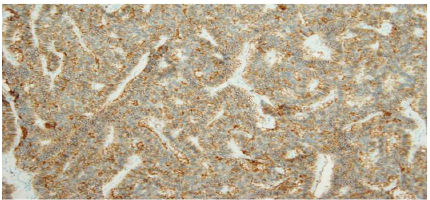
Figure 5: Neural cell adhesion molecule-stained section. Tumor cells are positive for neural cell adhesion molecule immunostain (magnification: ×